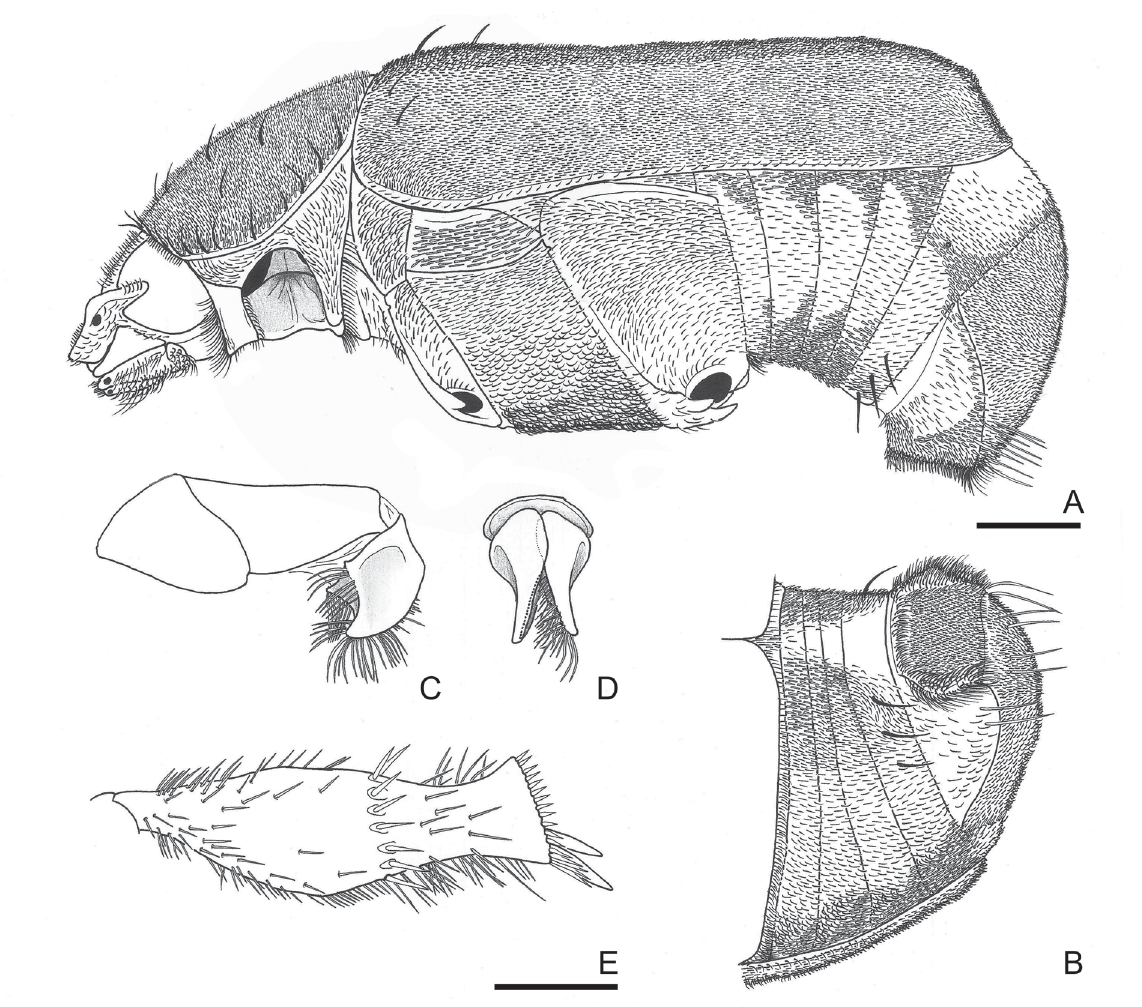
Fig. 7. Calodactylus tibialis Blanchard, 1850. A . Male habitus, lateral (without some appendages). B . Male abdomen lateroventral detail. C–D . Aedeagus (lateral, parameres apex). E . Metatibia. Scale bars = 1